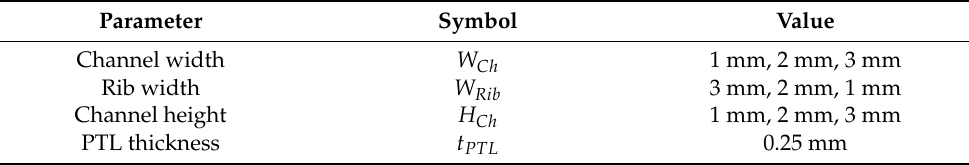
Figure 3. Schematic of the anode channel geometry with the channel flow field in the bipolar plate for PEMWE. Table 1. The geometric parameters of the flow field used in the PEMWE simulation with the two- phase flow model.